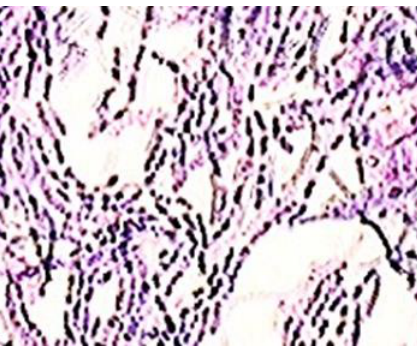
Figure 2. Gram’s staining of Streptococcus pyogenes (1000×).